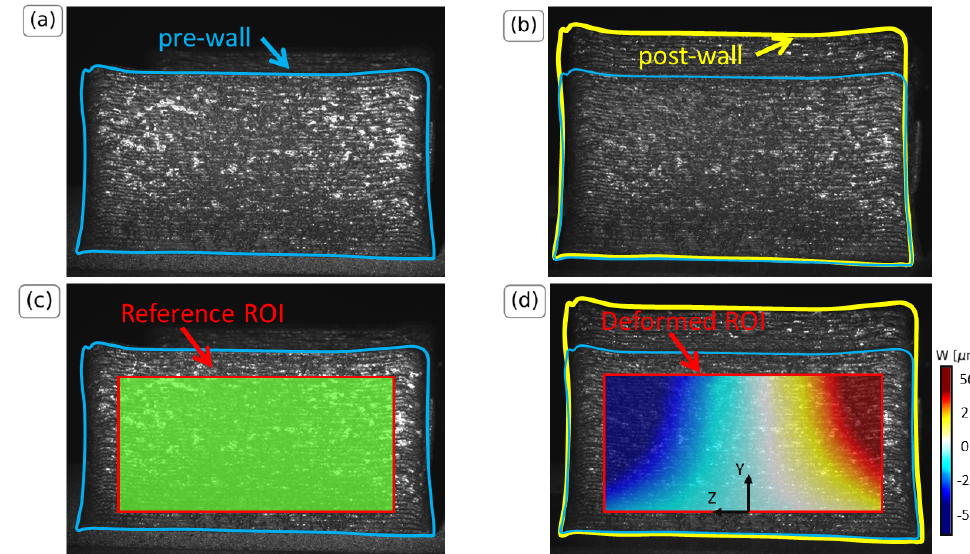
Figure 1. DIC images of the thin-wall samples. ( a ) Pre-wall geometry where the boundaries are indicated in blue, ( b ) post-wall geometry after the addition of 20 extra layers where the boundaries are indicated in yellow, ( c ) ROI used for the DIC for the reference state, ( d ) surface deformation W(Y,Z) of the post-wall geometry due to the expansion, where W is the in plane deformation in Z-direction. The values are indicative and are not explicitly used in the